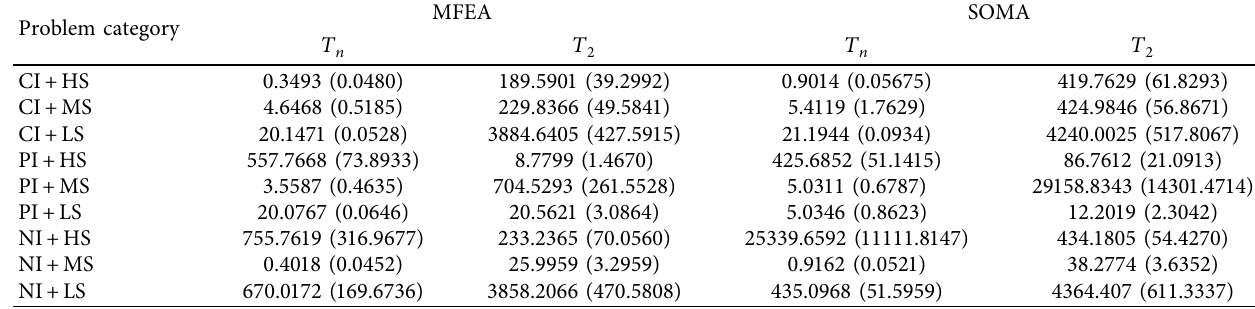
Table 5: Results of MFEA and SOMA on the multitask benchmark problem.